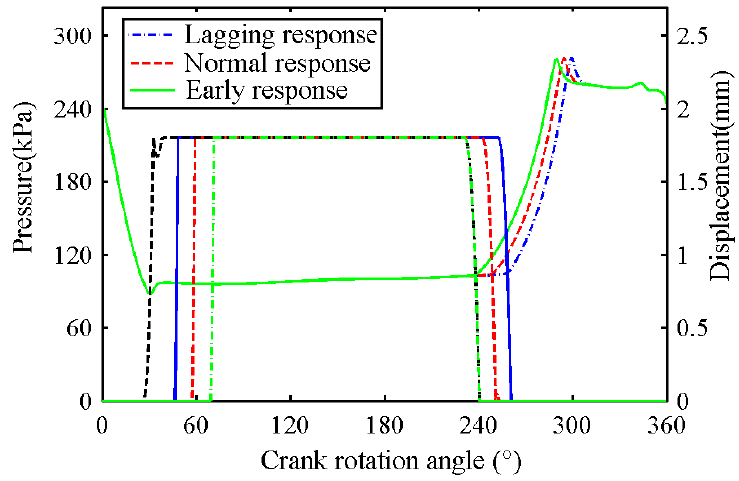
Figure 11. Solenoid valve response, valve plate displacement, and dynamic pressure.